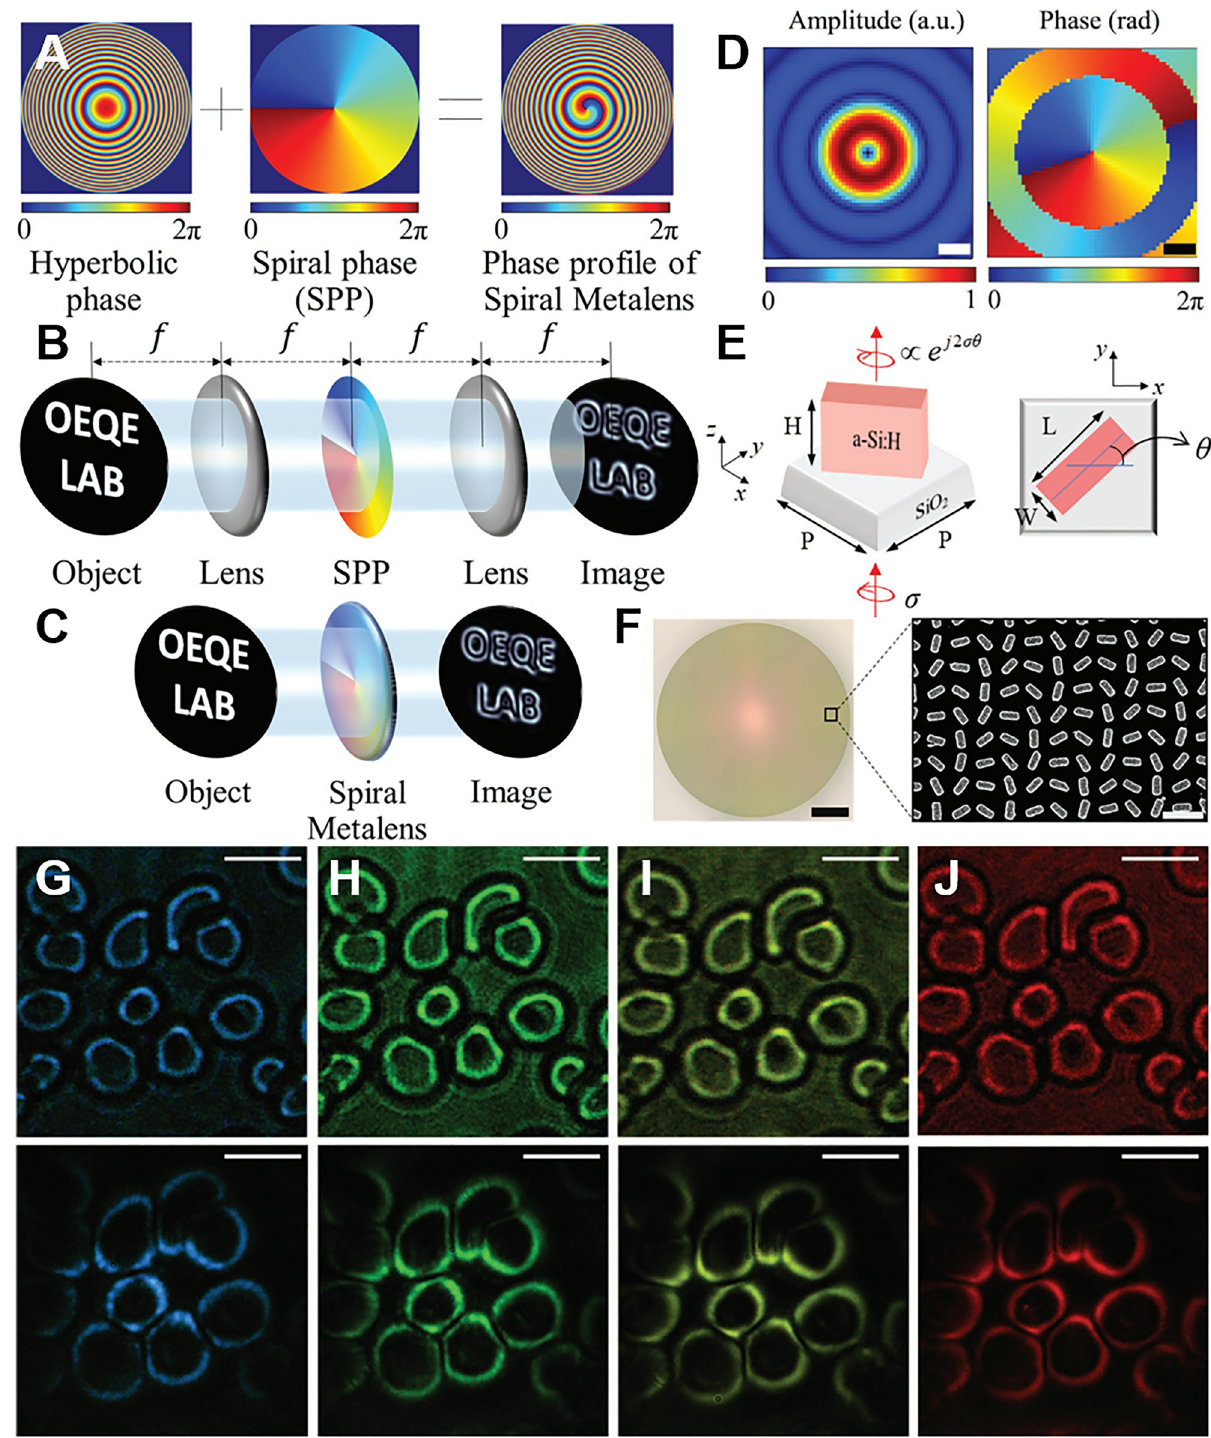
Figure 12: Spiral metalens for edge-enhanced imaging [134]. (A)Thephaseprofileofasingle-layerspiralmetalensisthesumofthehyperbolicphaseandthespiralphasewithatopologicalchargeof1.(B) Simplified optical device for traditional spiral phase contrast imaging. The spiral phase plate (SPP) is placed on the Fourier plane of the 4f system to produce an edge-enhanced image. (C) The spiral metalens is integrated by the lens and the spiral phase plate, which has a higher resolution to show the edge enhancement effect. (D) Numerically calculated amplitude and phase distribution of the spiral metalens on the Fourier plane. Scale bars, 250 nm. (E) The cell structure of the metalens is composed of a-Si:H on a SiO 2 substrate. The height, length,